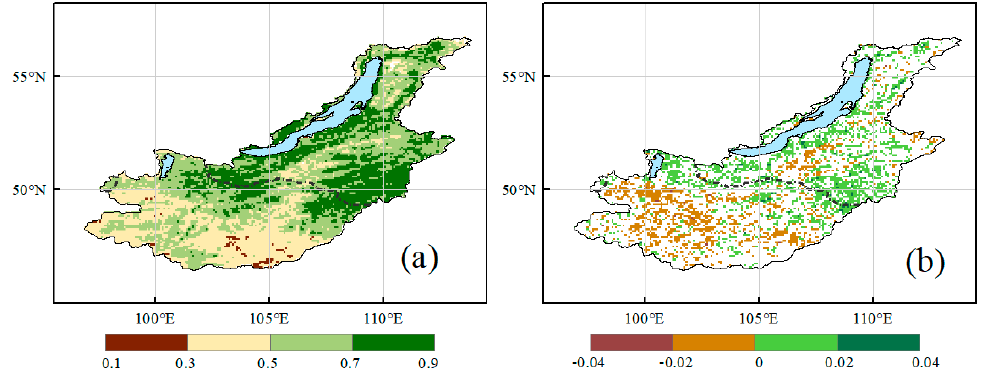
Figure 6. Spatial distribution of the ( a ) multiyear mean NDVI and ( b ) its trends ( p < 0.05) during the growing season from 1982 to 2015.